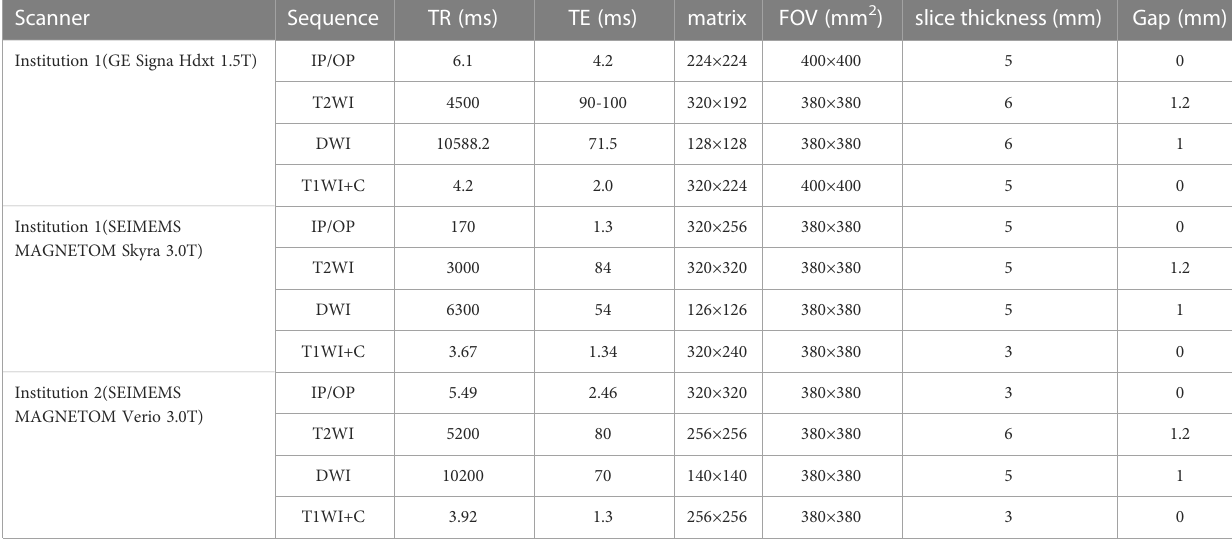
TABLE 1 Detailed parameters of T1-weighted imaging, T2-weighted imaging, diffusion weighted imaging in each institution. Scanner